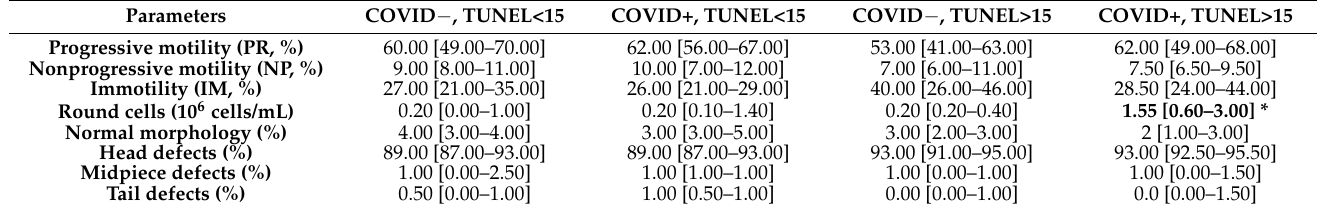
Table 2. Median and interquartile range of standard semen analysis parameters, selected morpholog- ical defects in the groups of